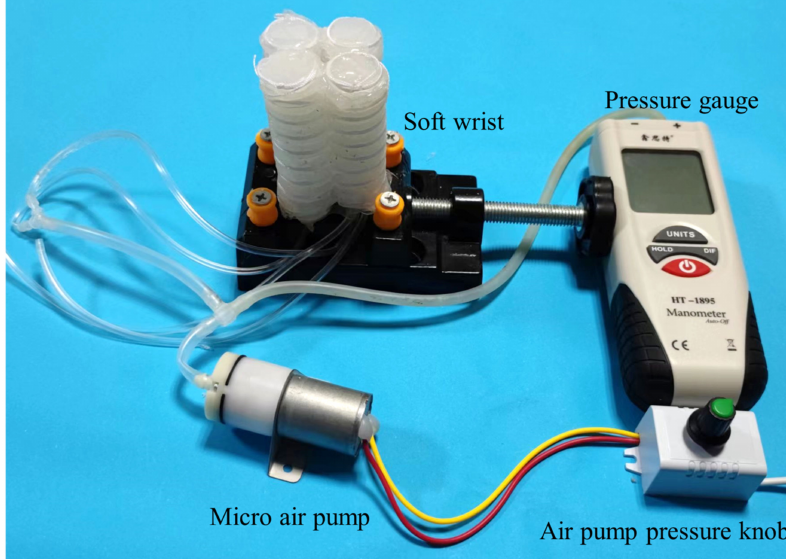
Figure 6. Experimental setup for measuring soft wrist motion.